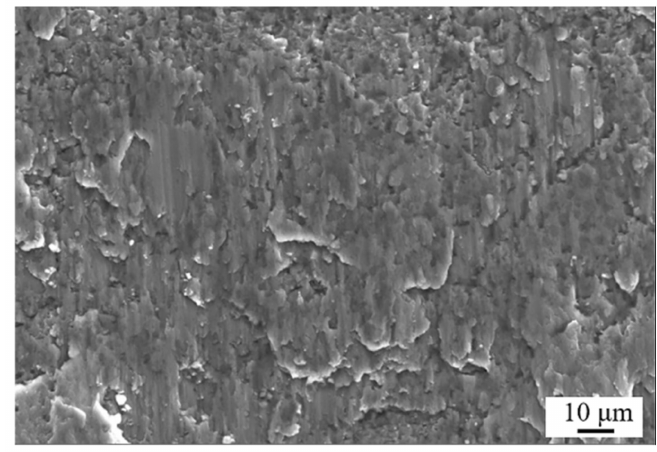
Figure 10. The shear fracture morphology of the shearing test.